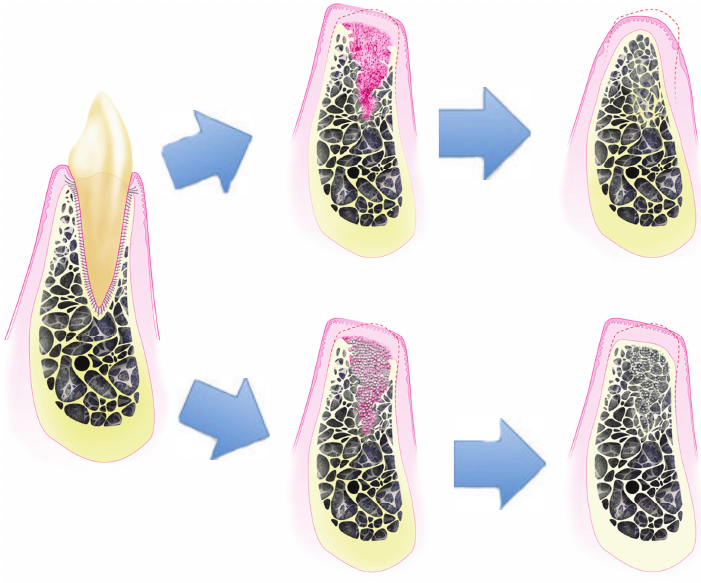
Figure 1: Healing of the extraction socket with and without socket grafting. When socket grafting is not adopted, major alveolar ridge resorption occurs. In a first phase, initially the blood clot, subsequently the granulation tissue and later the provisional matrix and the woven bone fill up the alveolus. The bundle bone is completely resorbed causing a reduction in the vertical ridge. In a second phase, the buccal wall and the woven bone are remodeled causing the horizontal and further vertical ridge reduction. When socket grafting is adopted, the first phase and vertical bone reduction still occur, however, the second phase and the horizontal contraction are